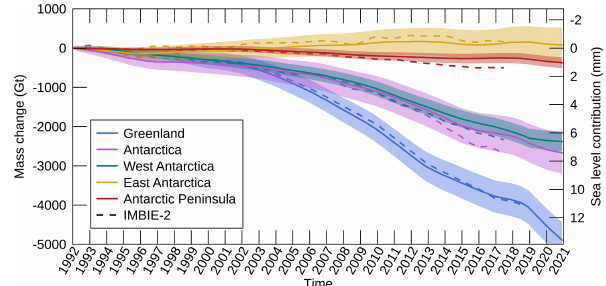
Figure 4. Cumulative ice sheet mass changes. The shadings rep- resent the associated uncertainties and are calculated following the procedure described in Sect. 3 (iv). The dashed lines show the re- sults from our previous assessments